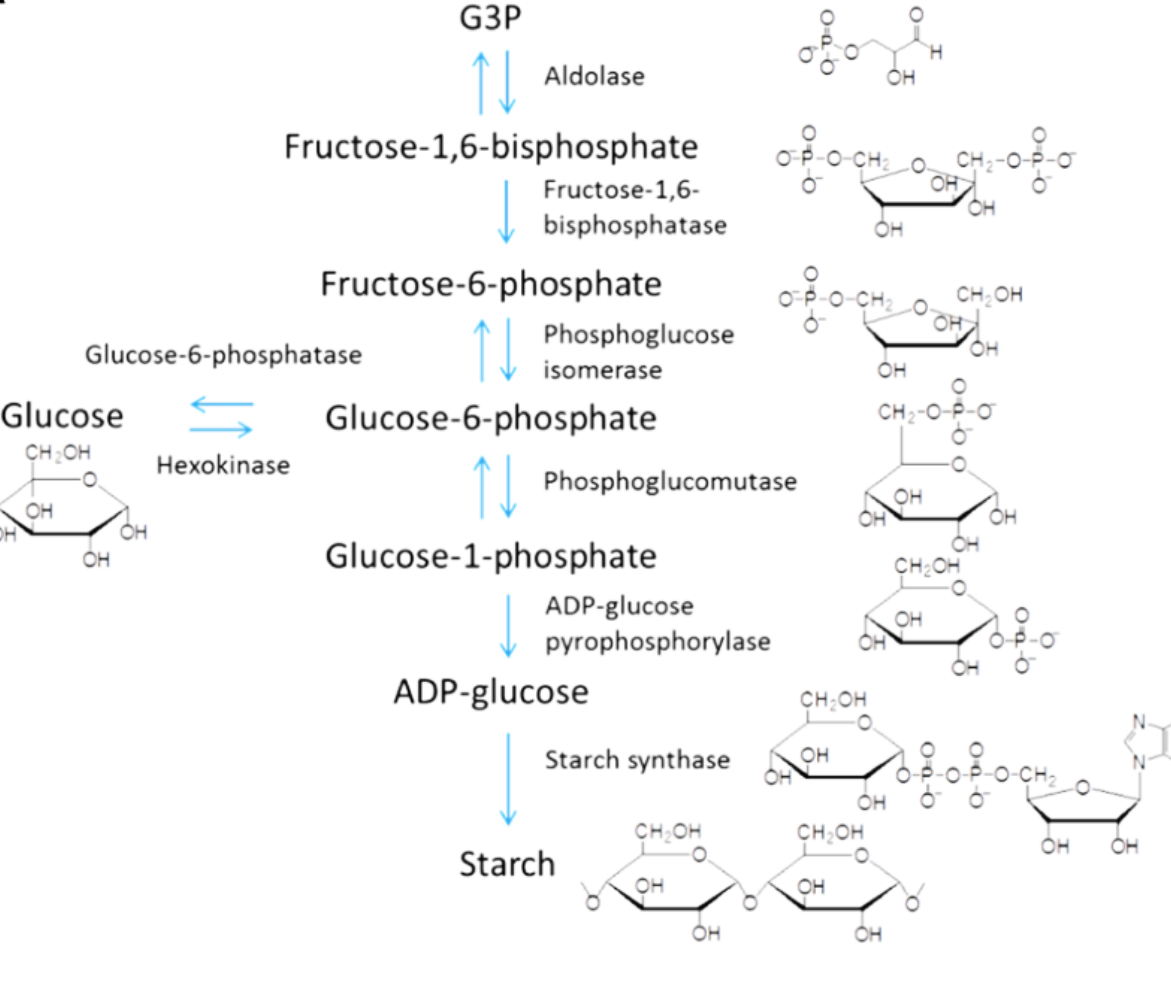
Figure 14. The conversion process of glyceraldehyde-3-phosphate (G3P) to ( a ) starch ； and ( b ) sucrose. Intermediates and enzymes are shown at each reaction